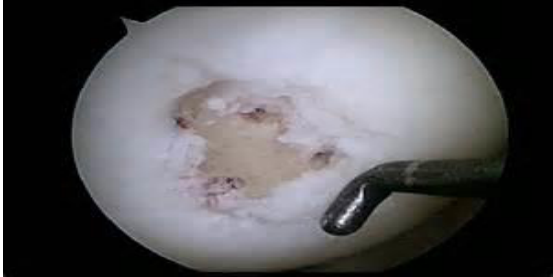
Fig 4After debridment of edges of lesion